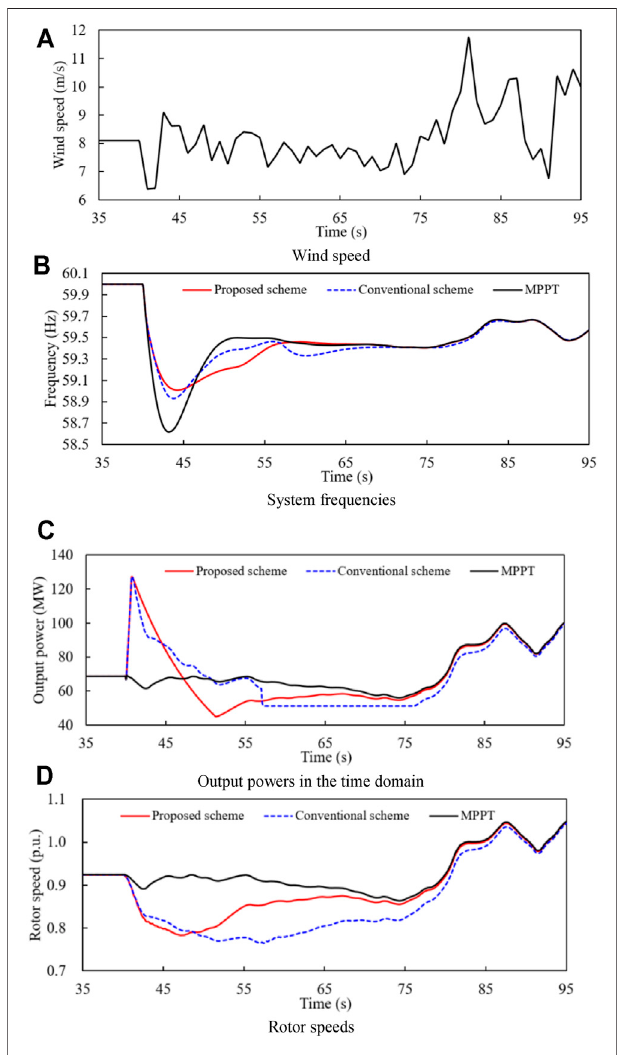
FIGURE 10 | Simulation results for case 3. (A) Wind speed. (B) System frequencies. (C) Output powers in the time domain. (D) Rotor speeds.